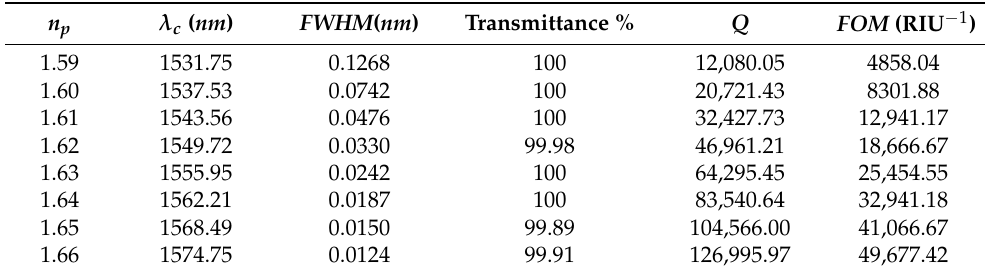
Table 2. The summary of sensing